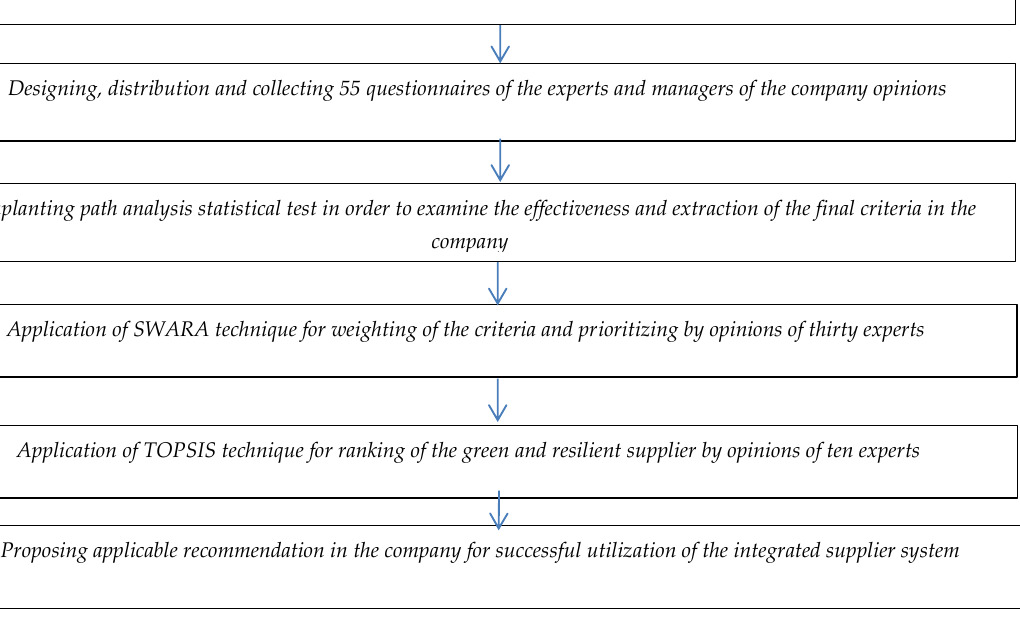
Fig. 2. Research methodology